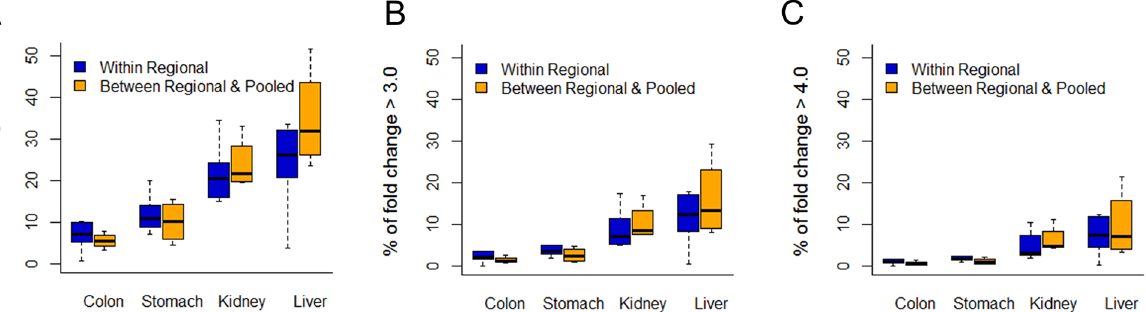
Fig 6. Percent of differentially expressed genes in multiregional samples (blue) and between the pooled sample and regional samples (orange). Each bar represents the distribution of the fraction of genes showing fold change difference in expression ((A) > 2-fold, (B) > 3-fold, and (C) > 4-fold) between each pair of samples. For every possible comparison between the four regional samples (a total of six comparisons) and between the four regional samples and the pooled sample (four comparisons) in each tumor case, genes showing a difference in fold change were selected for fraction